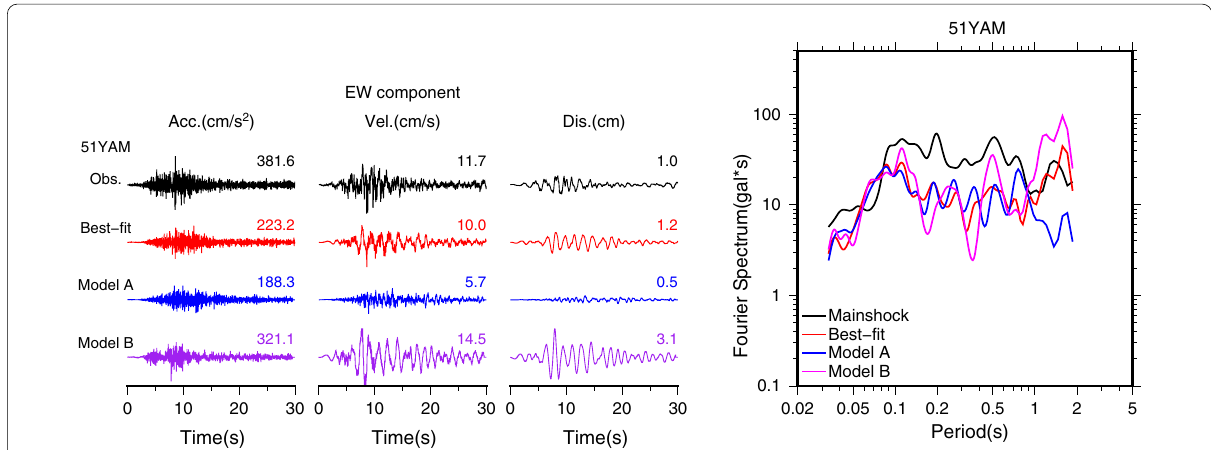
Fig. 11 Waveforms and acceleration Fourier spectra between the observed and synthesized ground motions in the EW component at Station 51YAM during the mainshock. The legends are the same as those in Fig. 10